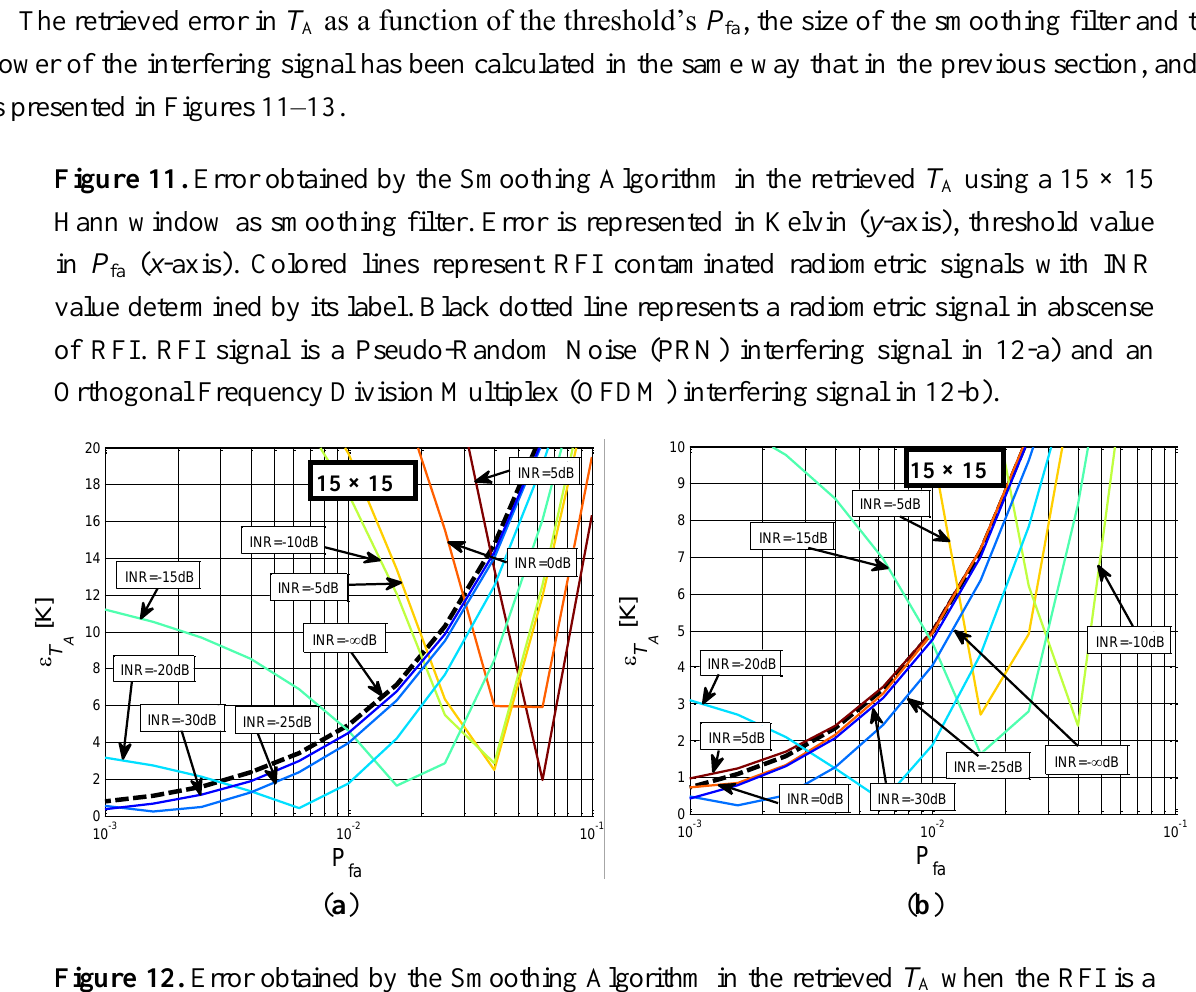
when the RFI is a A